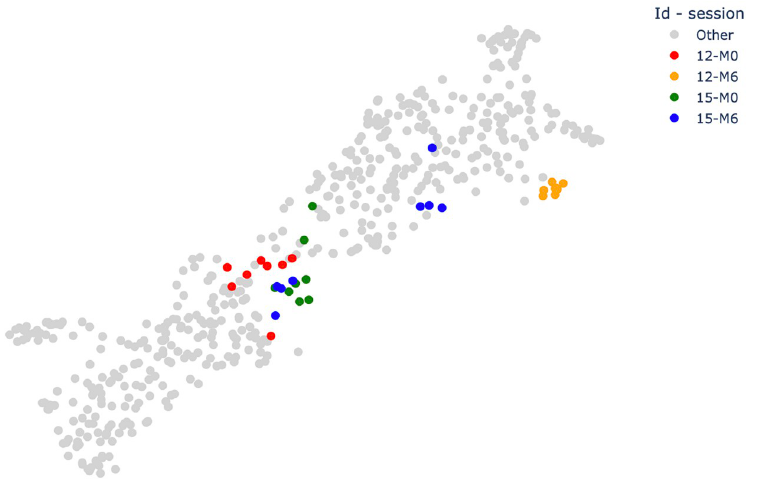
Fig 10. Longitudinal study of subjects 12 and 15. The point cloud is the same as on Figs 7 and 8 but colored differently. The red (resp. orange) points are the M0 (resp. M6) points of subject 12. The green (resp. blue) points are the M0 (resp. M6) points of subject 15. Grey points correspond to other